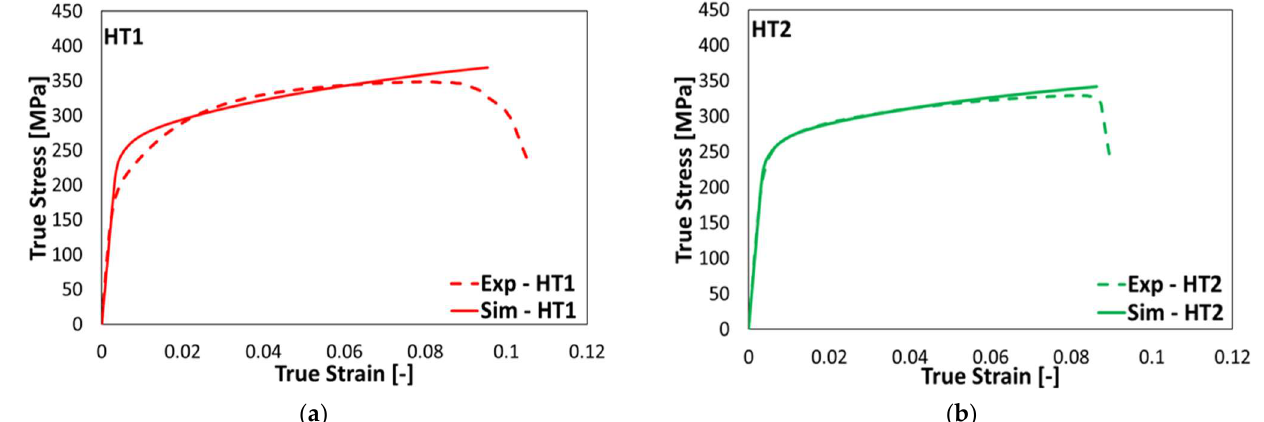
Figure 12. Comparison of the experimental and predicted tensile behavior using the combined crys- tal plasticity and J2 plasticity models of the PBF-LB/M AlSi10Mg HT states. ( a ) HT1 and ( b ) HT2